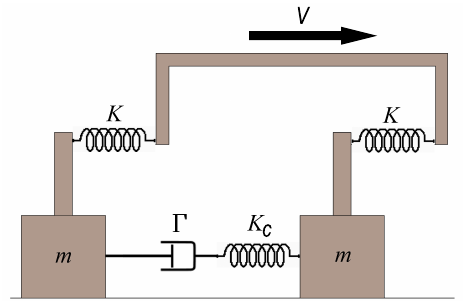
Fig. 1. Sketch of the